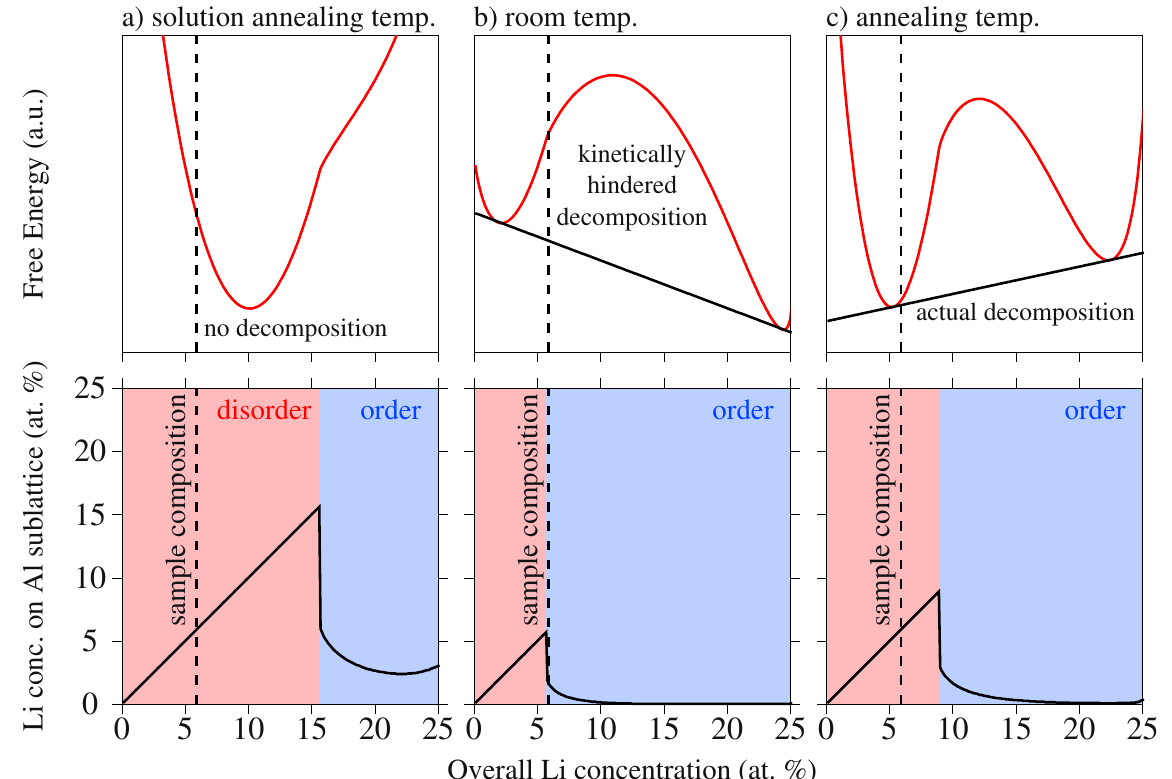
Figure 7. Free energy curves according to the BWG model at three different temperatures, namely solution treatment temperature ( a ), room temperature ( b ) and annealing temperature ( c ). The upper part of the figure shows the calculated free energy curves for fixed homogeneous composition, but free degree of long-range order, while the lower part illustrates the corresponding long-range order parameter via the Li concentration on the Al